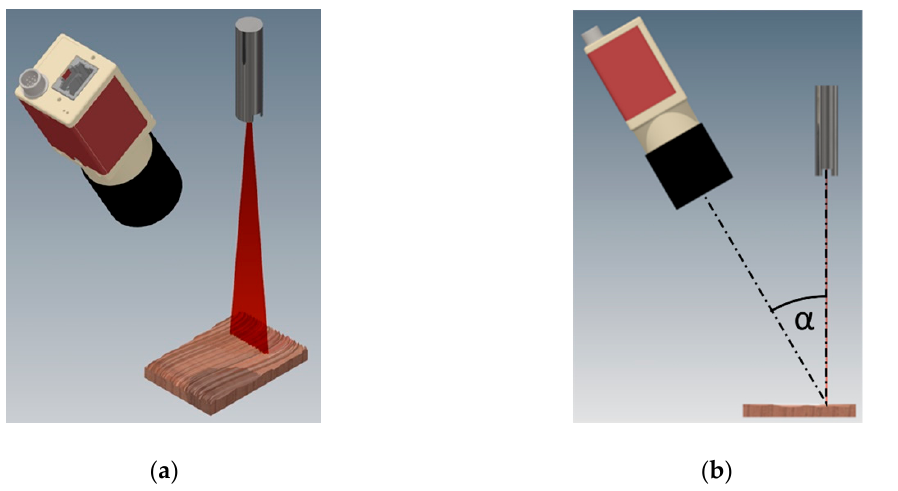
Figure 2. Visualization of the laser triangulation system, with laser line projected on the object and camera capturing pictures: ( a ) isometric view; ( b ) geometry of 3D vision system.